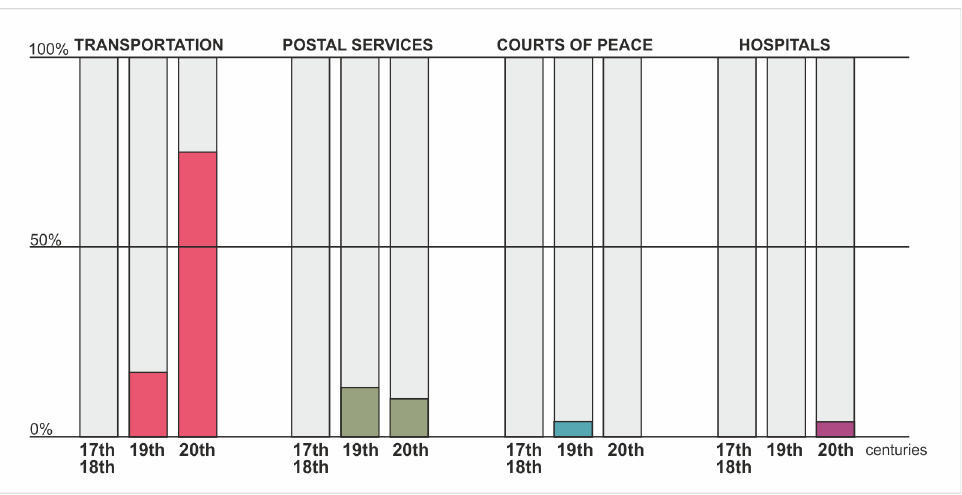
Fig. 4. Percentage of the city maps of Warsaw presenting information about services and offices in the total number of city maps in three